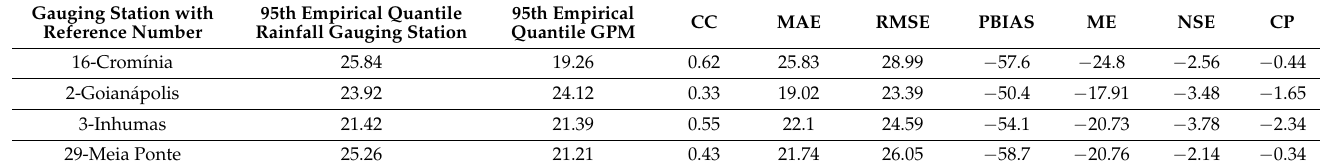
Table 5. Goodness-of-fit metrics for daily rainfall amounts above the 95th empirical quantiles from four gauging stations located in the Meia Ponte River catchment.